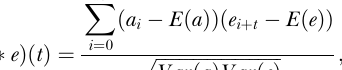
ffiffiffiffiffiffiffiffiffiffiffiffiffiffiffiffiffiffiffiffiffiffiffiffiffiffiffi p Var ð a Þ Var ð e Þ